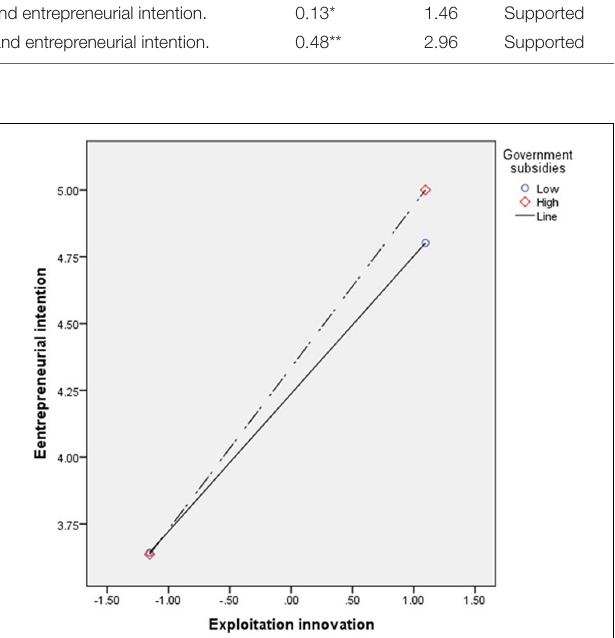
FIGURE 2 | The interaction effect of exploration innovation and government subsidies on entrepreneurial intention.